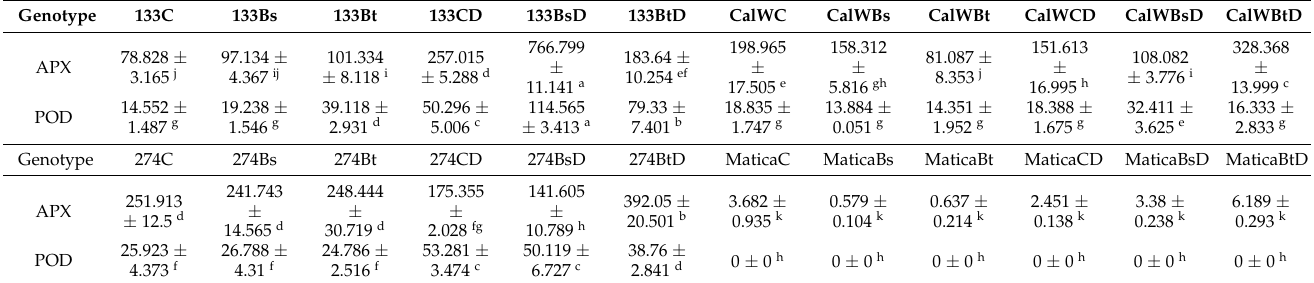
Different letters show significant differences between genotypes ( p < 0.05) according to Duncan’s